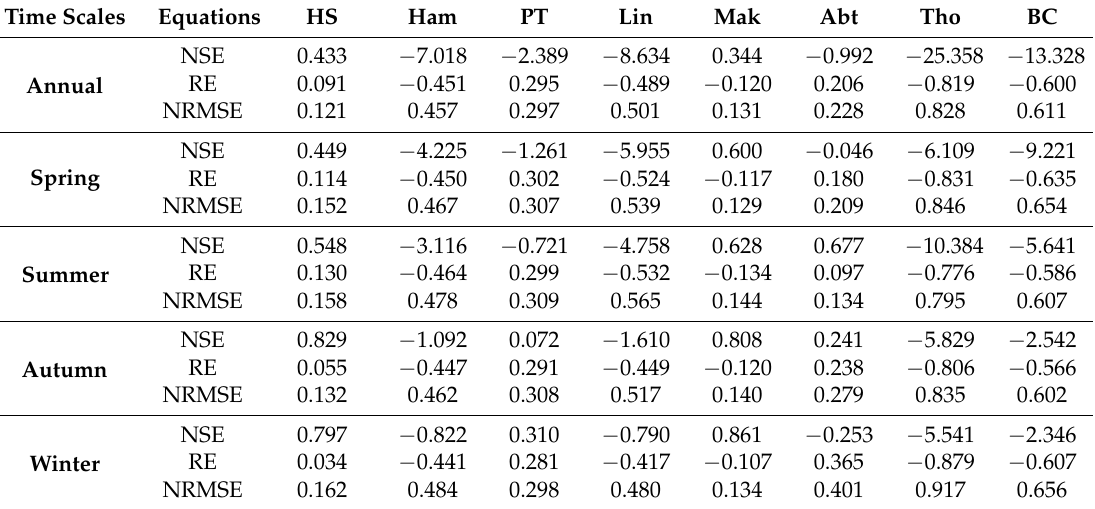
Table 6. Accuracy assessment of PET estimation in the arid river valley